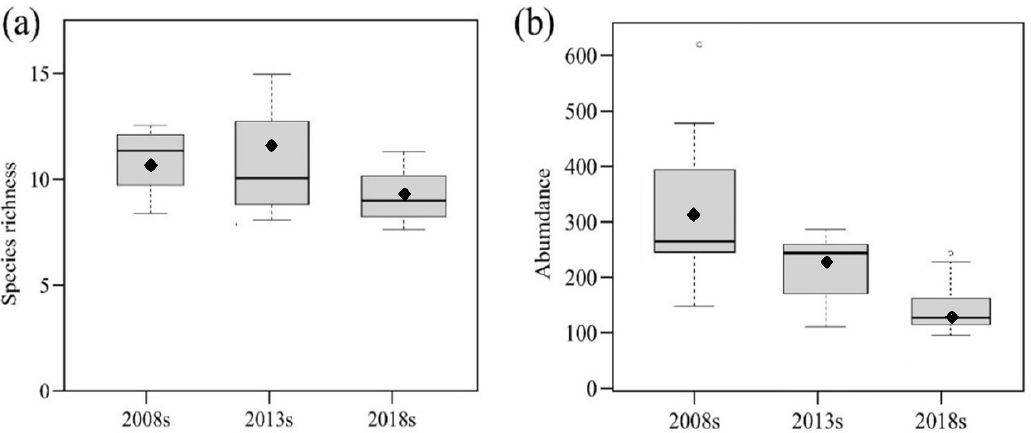
Figure 2. Boxplots of carabid beetle species richness ( a ) and abundance ( b ) per survey at five-year intervals. The upper and lower edges represent upper and lower quartiles, the bold black lines represent median values, and the black rhombuses indicate means. Table 2. Summary of generalized additive regression for the dependent variables of abundance and